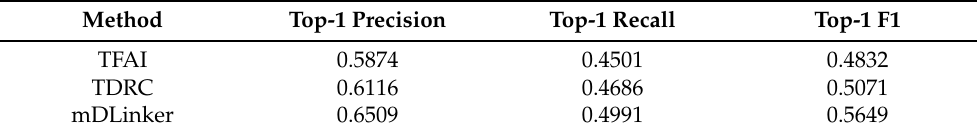
Table 2. Performance comparison among TFAI, TDRC and mDLinker under the setting CV-Type.